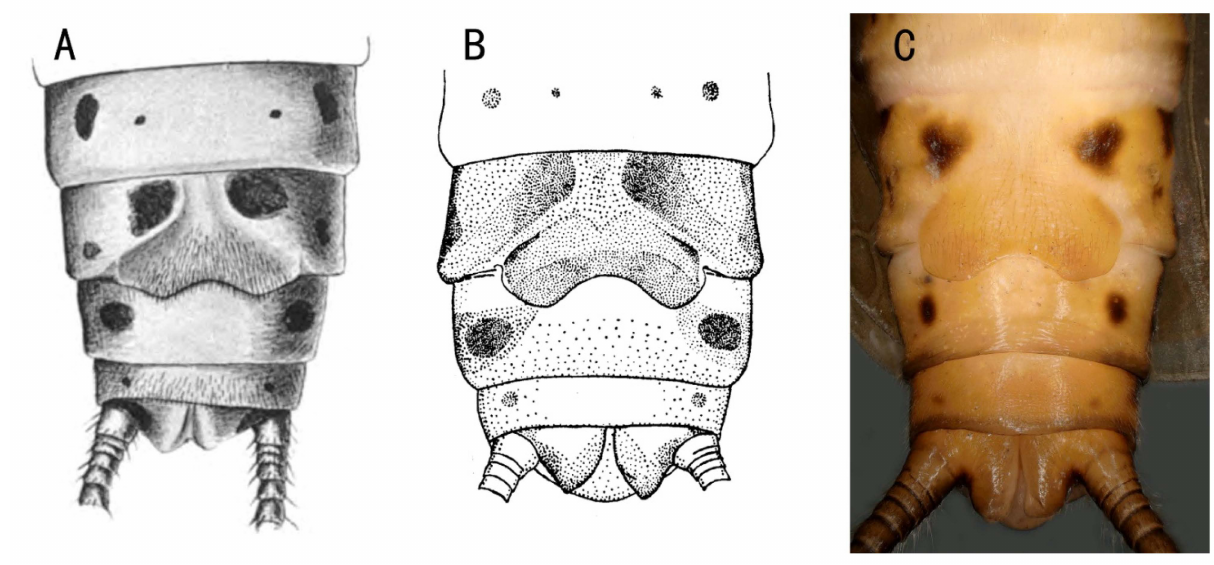
Figure 2. Terminalia of females, ventral: ( A ) Filchneria mongolica , in Klap á lek [2]; ( B ) Filchneria mon‑ golica , in Teslenko and Zhiltzova [6]; ( C ) Filchneria songi